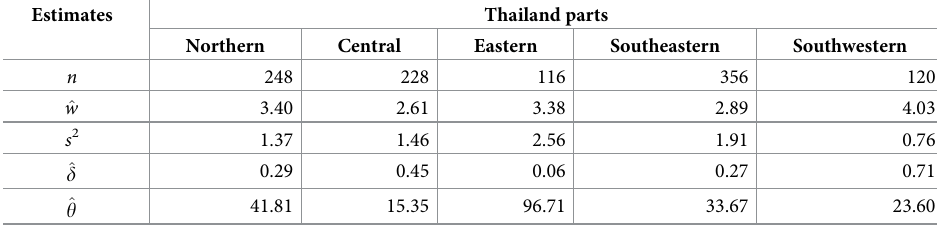
Table 5. Estimated parameters for five parts in Thailand.